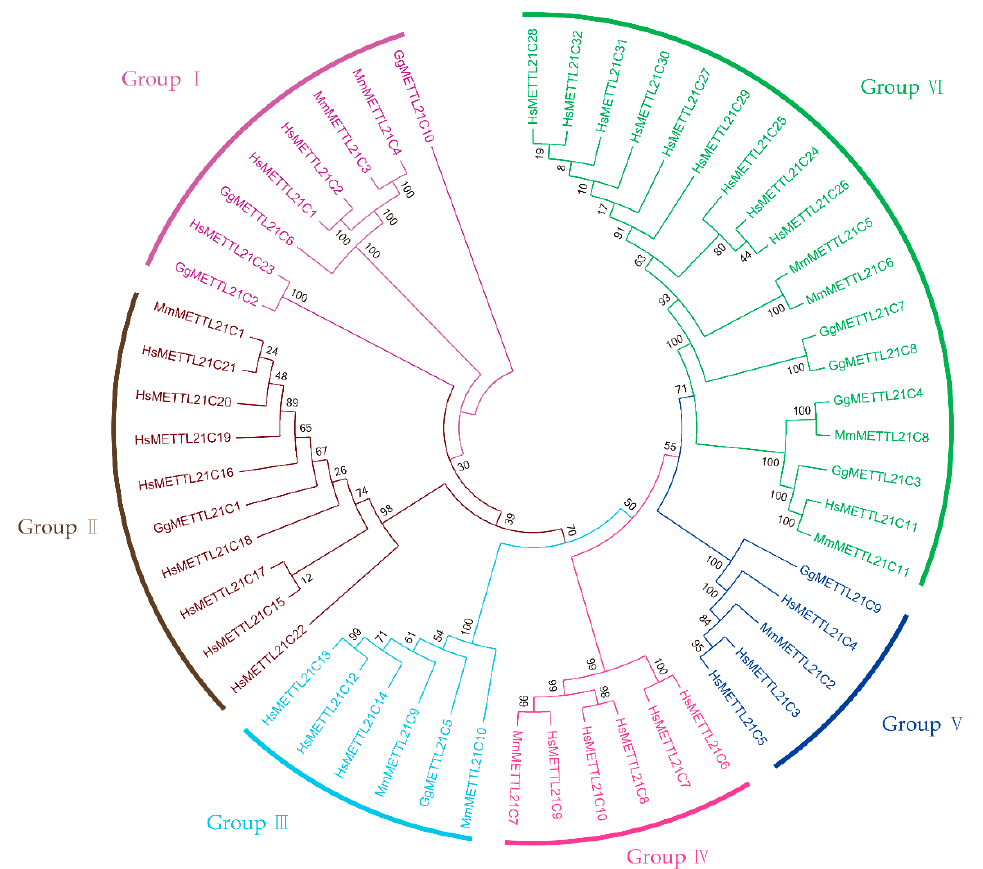
Figure 1. Phylogenetic analysis of methyltransferase-like 21C (METTL21C) proteins in G. gallus domesticus , M. musculus , and H. sapiens . These 53 sequences were used to construct a neighbor-joining (NJ) tree. The tree was divided into six groups (I–VI); the names of the different groups are displayed.